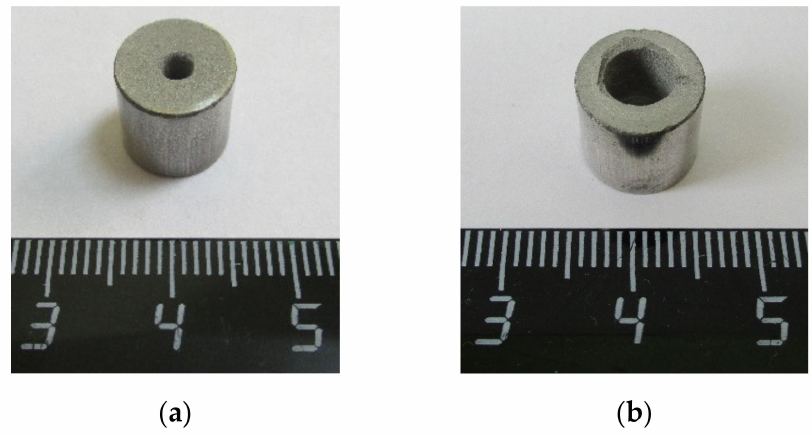
Figure 1. Ni-Al powder cylindrical samples: ( a ) for ampoule No. 1; ( b ) for ampoule No. 2.